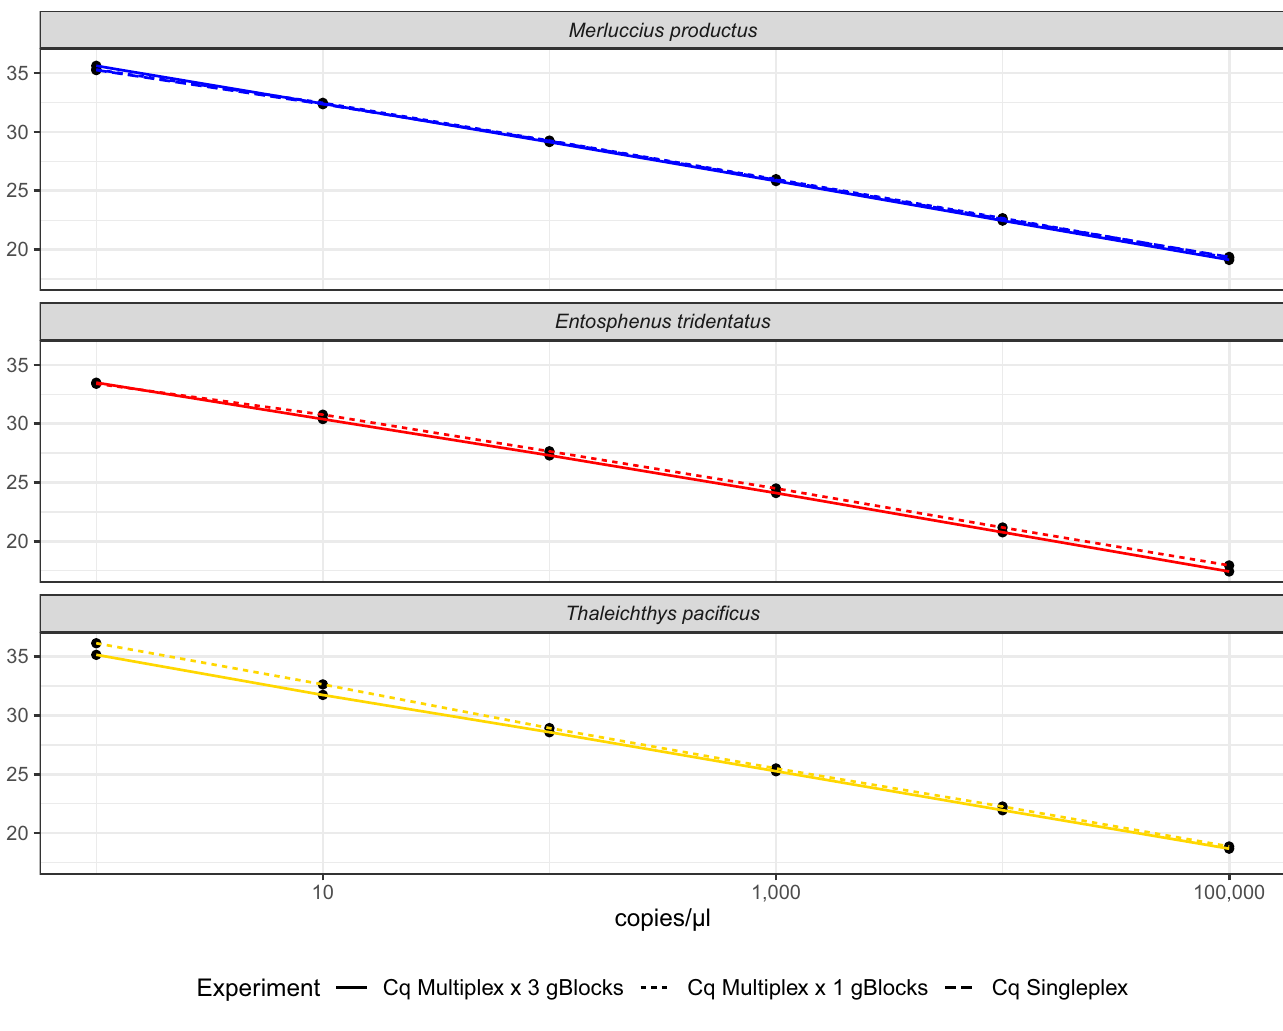
Fig 4. Comparison of the performance of the standards of the triple assay in a multiplex with 1 and 3 gBlocks per species. The performance for Merluccius productus in a singleplex is also